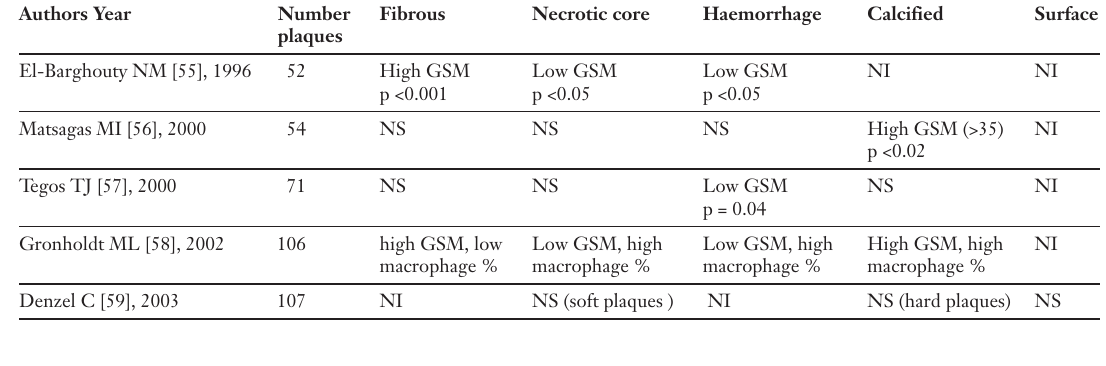
A. The plaque is delineated by colour Doppler flow imaging at its surface and by adventitia at the bottom (yellow arrow). B. Colour Doppler flow imaging is switched off. Colour mapping of the plaque (yellow arrow). shows the following proportions for the whole plaque: red 38% (GSM <50), yellow 24% (GSM >50 and <70) and green 6.7% (GSM >70); for the surface of the plaque the colours are distributed as fol- lows: red 68%, yellow 38% and green 27%.